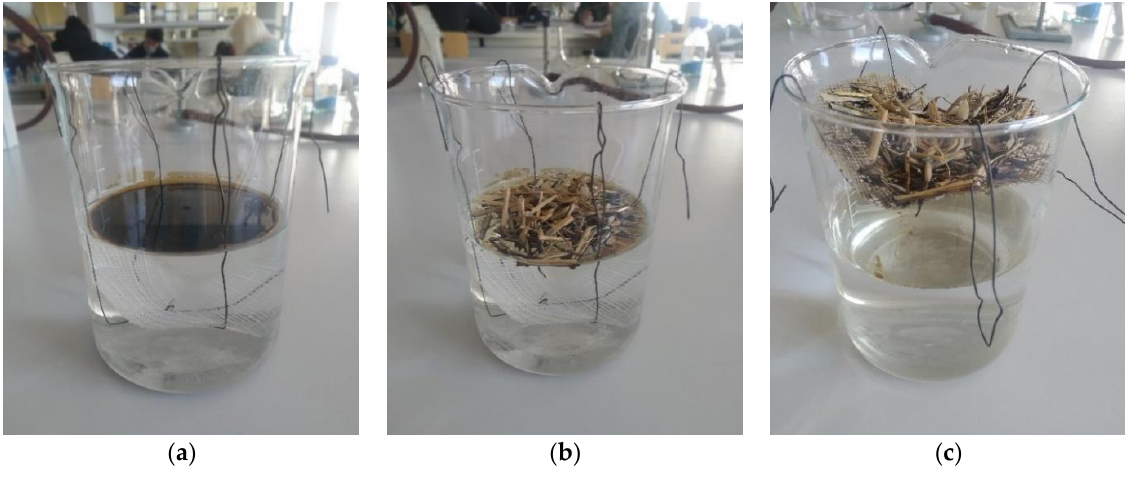
Figure 1. Analysis of THC in the aquatic system: ( a ) sea water with crude oil film; ( b ) sea water with crude oil and sorbent (straw) on it; ( c ) view of the water draining process after the experiment.